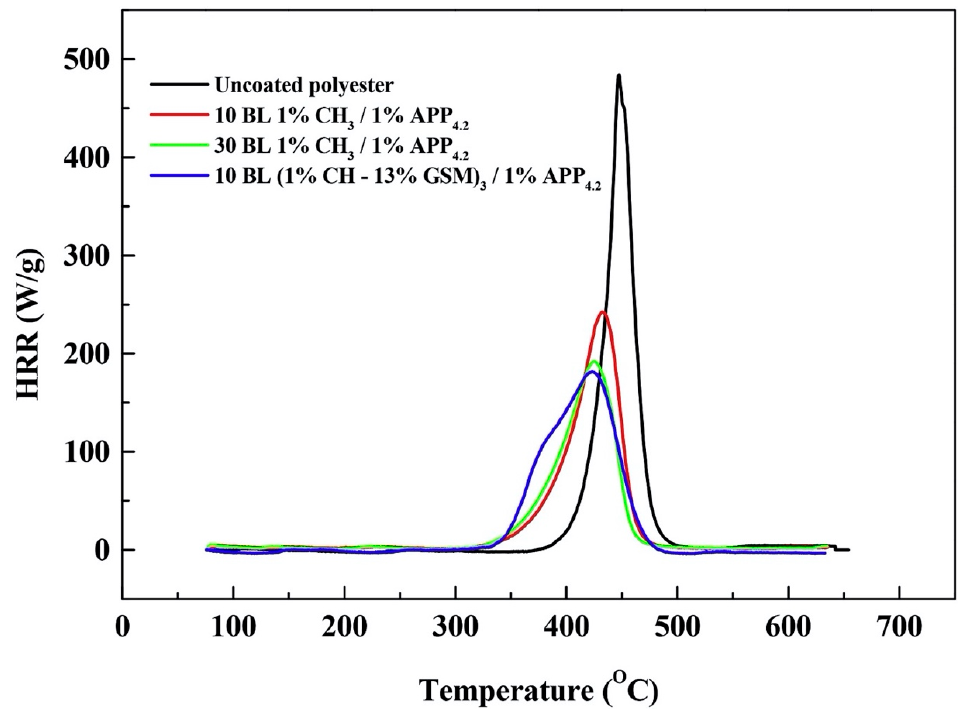
Figure 15. Results from pyrolysis-combustion flow calorimetry tests performed on untreated and LbL-treated polyester fabrics. 10 BL 1% CH 3 /1%APP 4.2 : assembly made of 10 bilayers of chitosan and ammonium polyphosphate; 30 BL 1% CH 3 /1%APP 4.2 : assembly made of 30 bilayers of chitosan and